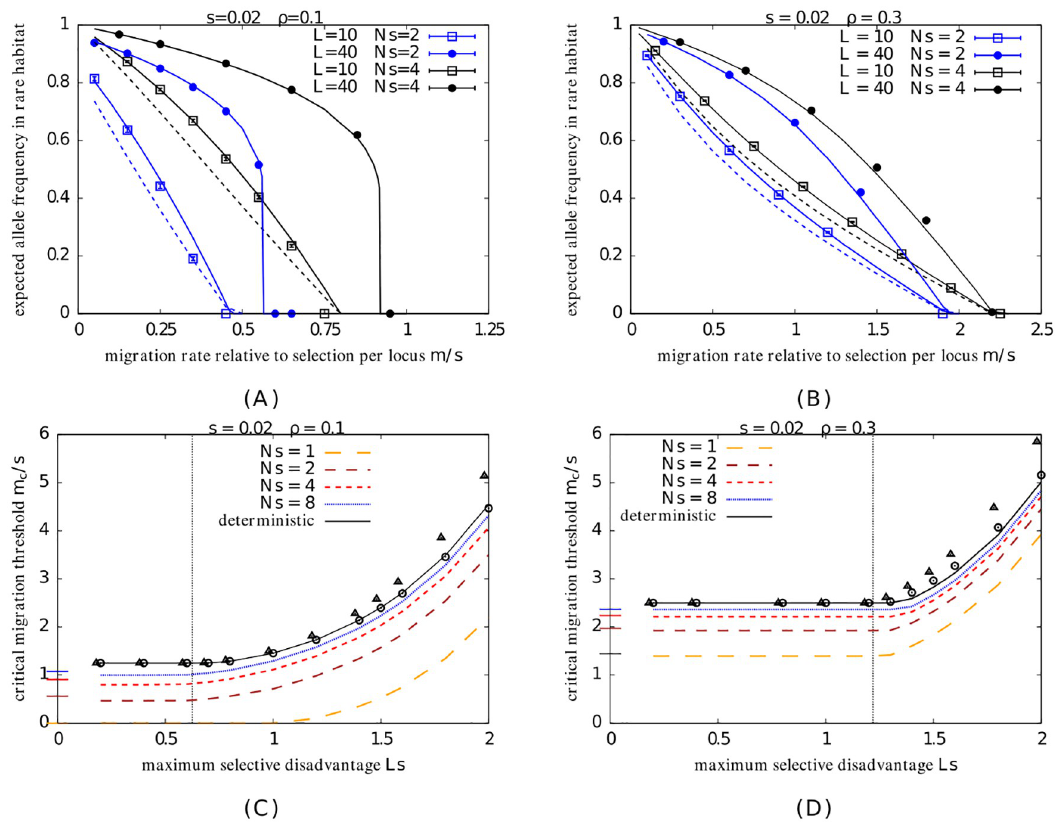
Fig 2. Local adaptation in the infinite-island model with two habitats. A–B. Expected equilibrium frequency of the locally adaptive allele in the rare habitat vs. m / s for ρ =0.1 (Fig 2A) and ρ =0.3 (Fig 2B), for 2 different values of L (10 and 40; squares vs. circles), and two different population sizes (corresponding to Ns =2 and Ns =4; blue vs. black). Symbols depict results of individual- based simulations; solid lines depict theoretical predictions that account for both LD and drift (obtained using Eq (8) together with Eq (4)); dashed lines depict LE (i.e., single-locus) predictions that only account for drift (obtained from Eq (2)). Selective effect per deleterious allele is s =0.02 in both plots. The number of simulated demes is D =500 in all individual-based simulations; the average allele frequency is obtained by averaging over all L loci and all ρD islands in the rare habitat, across 5 simulation replicates. C–D. Theoretical predictions for m / s , the critical migration threshold scaled by the per-locus selection coefficient, vs. Ls for ρ =0.1 (Fig c 2C.) and ρ =0.3 (Fig 2D.), for s =0.02 and N =50, 100, 200, 400 (corresponding to Ns =1, 2, 4, 8 respectively). Here, m c is the critical migration threshold above which local adaptation cannot be maintained in the rare habitat. Theoretical predictions are obtained by solving for the polymorphic equilibrium of Eq (8) (using Eq (4)) and determining the value of m above which no such equilibrium exists. The short horizontal colored lines along the vertical axis represent the approximate LE (single-locus) prediction m c � s h i� � 1 (see [38]). The exact deterministic predictions for m 1 (cid:0) 1 / s (obtained by solving coupled deterministic equations log 1 (cid:0) r c r 1 (cid:0) 2 r 2 Ns for p and p ; see eq. 12 in Section 5 in S1 Text) are shown using solid black lines. The critical migration rate m / s is constant for small r c c Ls , but then starts increasing with Ls beyond a threshold ( Ls ) � . The deterministic prediction for ( Ls ) � is depicted by vertical dotted lines and depends only on the habitat fraction ρ (see text). In addition, we also show approximate deterministic predictions for m / s c (triangles and circles)—for Ls > ( Ls ) � and in the highly polygenic limit s ! 0, L ! 1 with Ls constant, the deterministic m / s is given c by Eq (10a) and is shown using triangles. Predictions that are more accurate at somewhat larger s are obtained in Section 5 in S1 Text (see eq. 17B in S1 Text). These are shown using circles and agree well with the numerically obtained deterministic m / s (solid black c